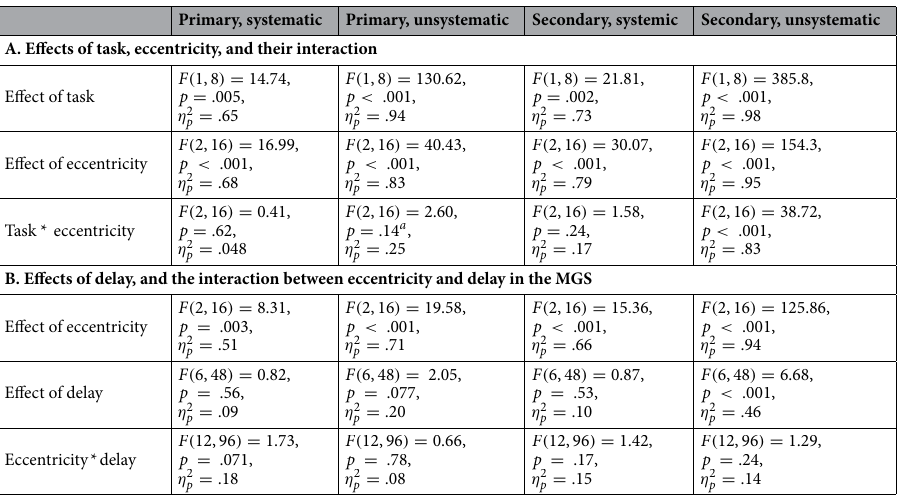
Table 2. Repeated-measures analyses of variance on VSWM errors in Experiment 2. “a” indicates p-value corrected by the Greenhouse–Geisser method due to violation of sphericity.